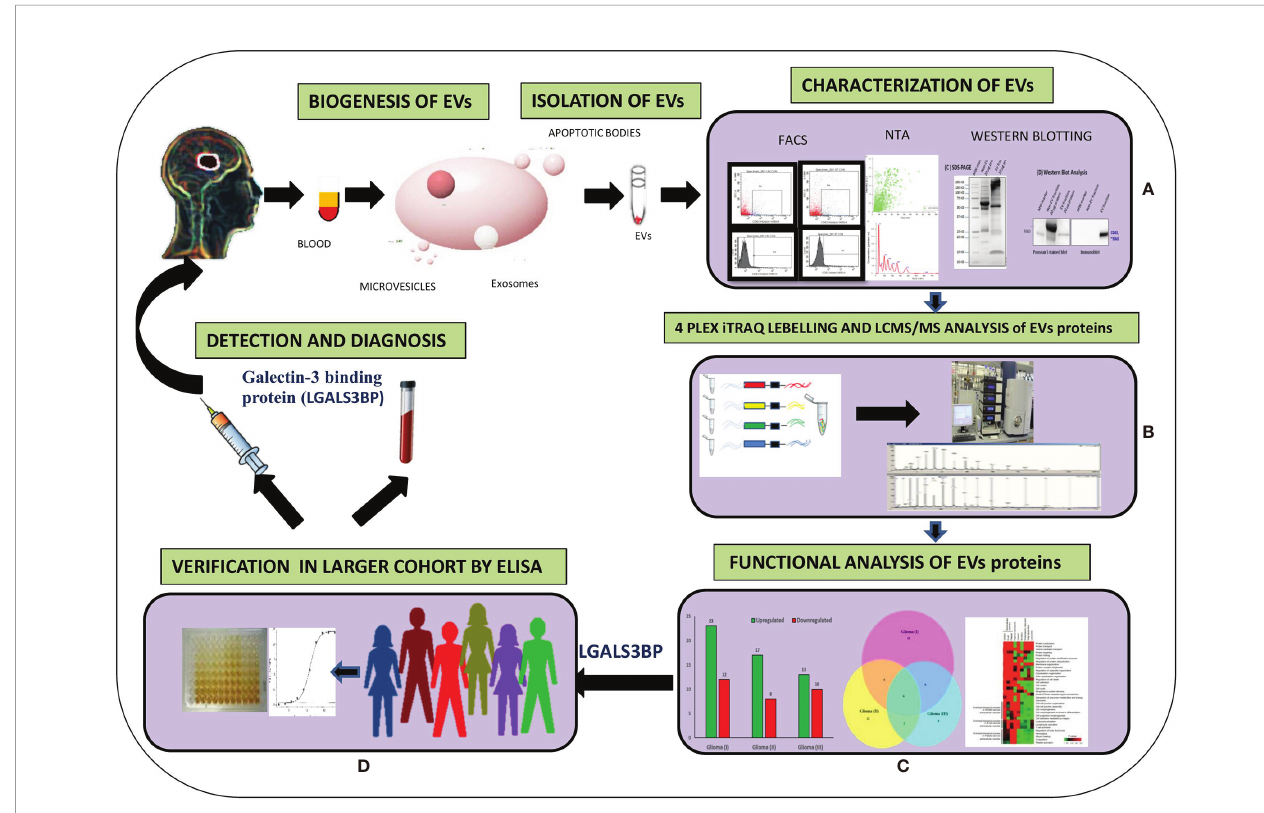
FIGURE 1 | Graphical representation of methodology. (A) Extraction of EVs from plasma and characterization and quanti fi cation of EVs from different techniques. (B) Isobaric tag for relative and absolute quantitation (ITRAQ) labeling and Liquid Chromatography with tandem mass spectrometry (LC-MS/MS) analysis of EVs proteins. (C) Functional analysis of EVs altered proteins in different grades of Glioma. (D) Veri fi cation by Enzyme-linked immunosorbent assay